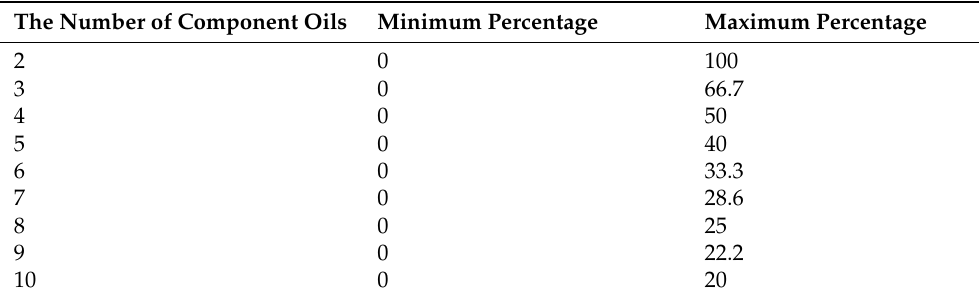
Table 1. The maximum percentage of each oil for edible oil blends with different number of component